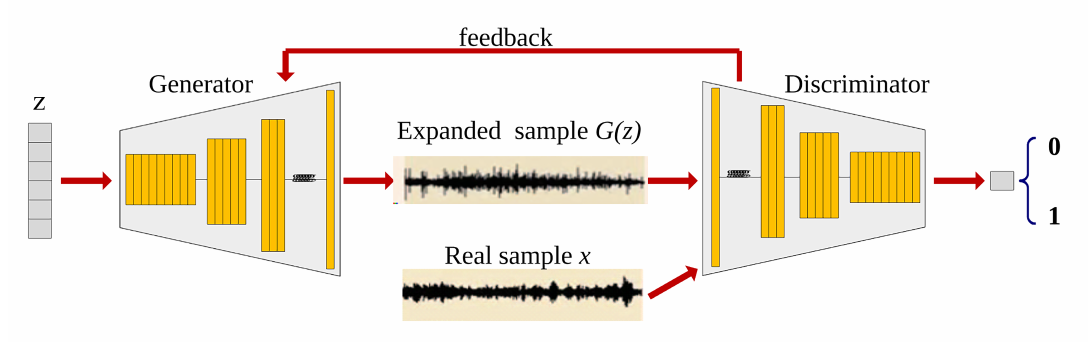
Figure 1. The Acoustic Fault Generative Adversarial Network (AFGAN)